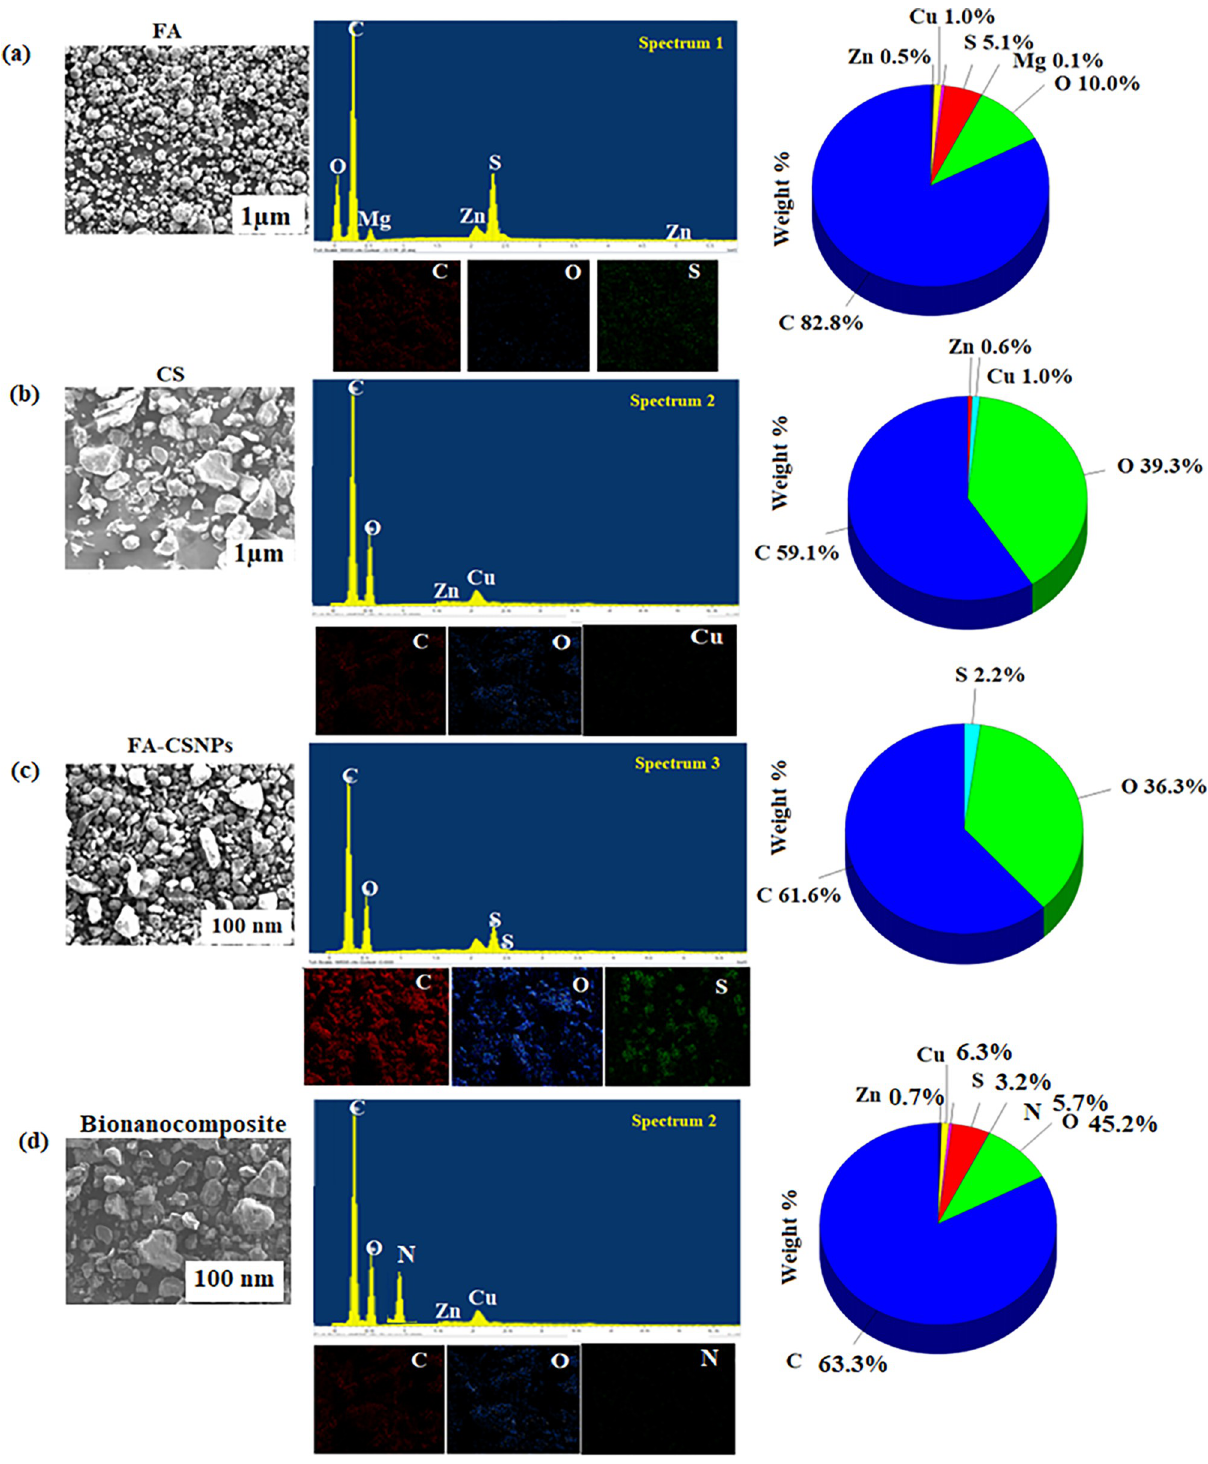
Fig 4. SEM and EDS images, elemental mapping, and weight % of (a), FA. (b) CS, (c) FA–CSNPs, and (d) sunflower oil–FA–CSNPs bionanocomposite film.